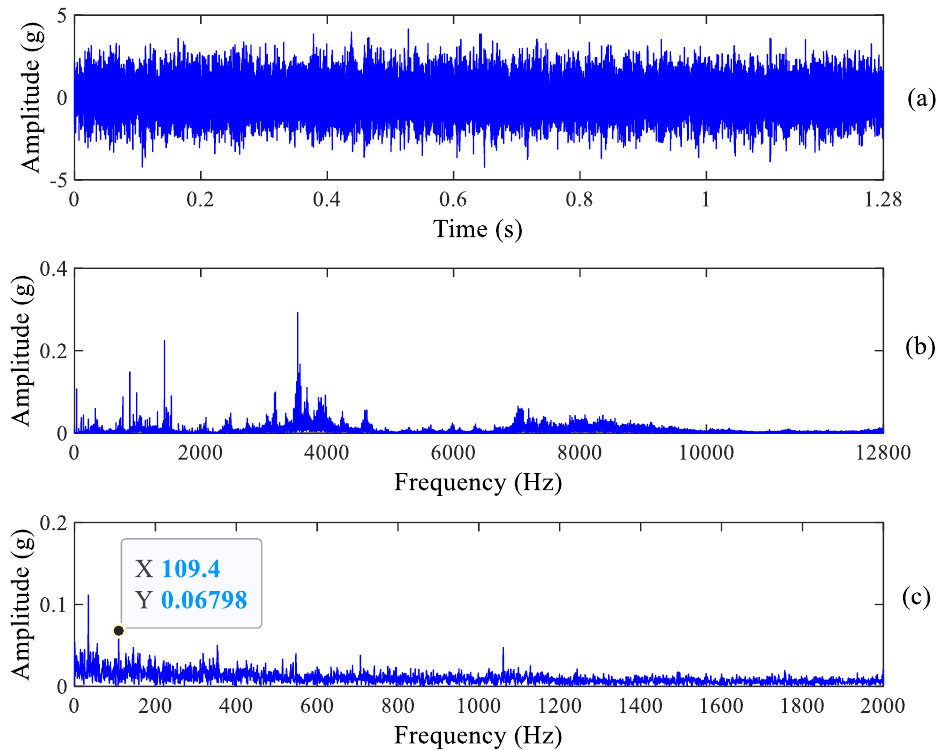
Figure 5. Horizontal raw vibration signal and its spectrum. ( a ) Raw signal, ( b ) Frequency spectrum and ( c ) Zoomed envelope